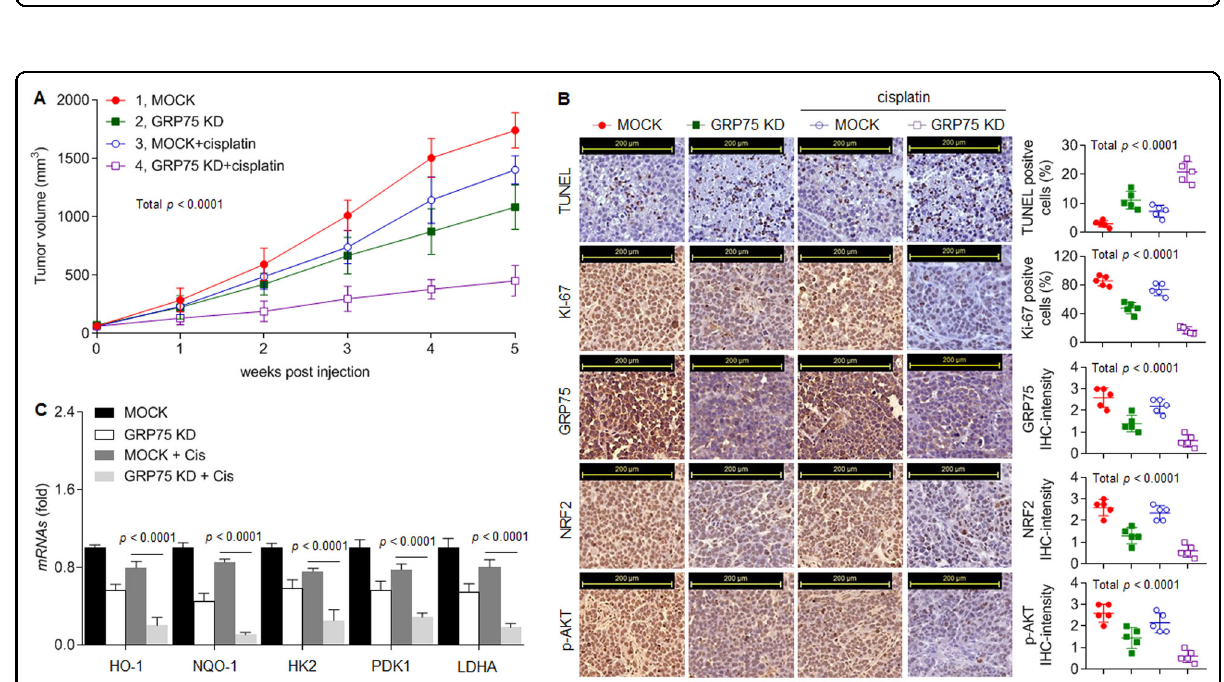
Fig. 5 Con fi rmation of the in vitro data in a xenograft model. The SGC7901 CR cells xenograft tumors were treated by GRP75 siRNA alone, cisplatin alone, or cisplatin plus GRP75 siRNA. A The volumes of xenografts tumors in different treatments described above. B Tunnel and IHC staining (Note: each point represented the mean of one xenografts tumor section calculating in 5 high-power fi elds). C qPCR analysis in triplicate of the expressions of HO-1, NQO-1, HK2, PDK1, and LDHA mRNAs in xenografts